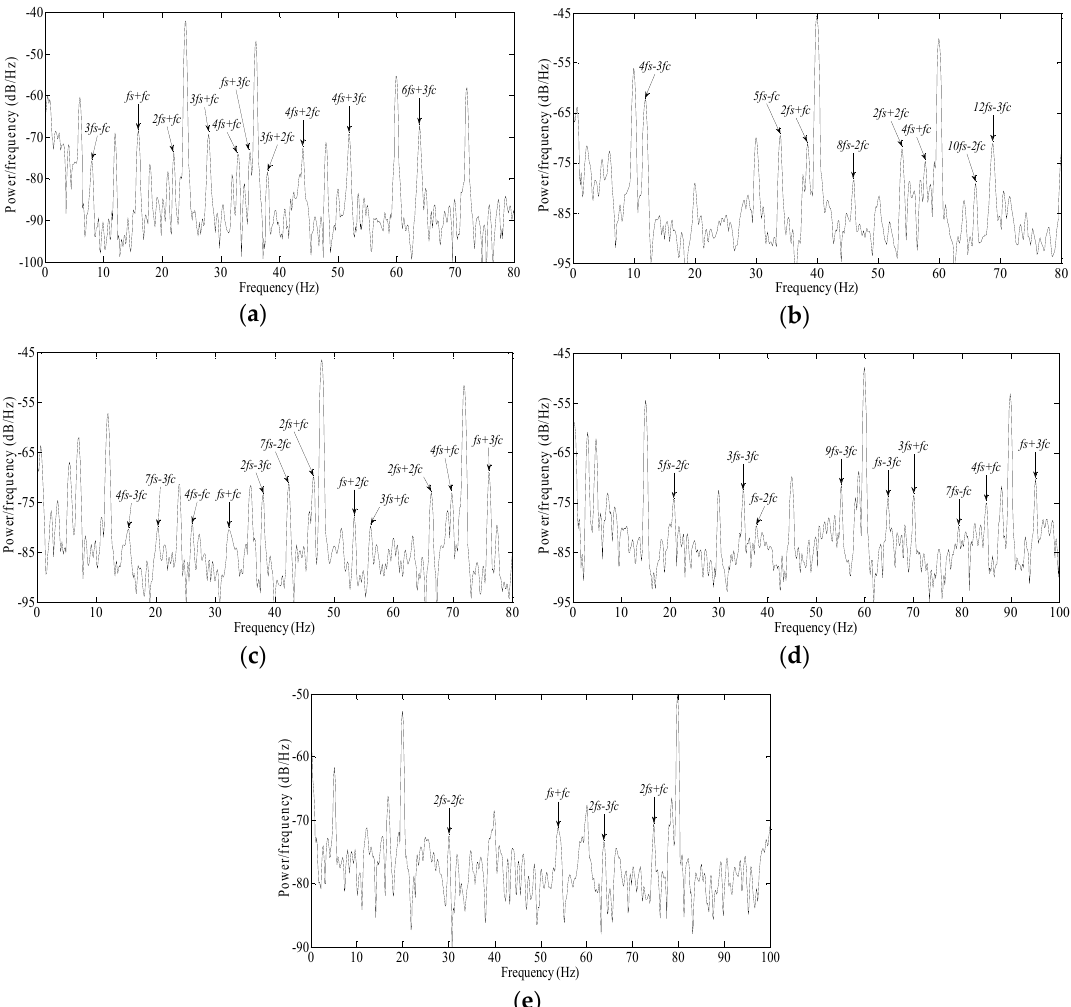
Figure 16. The squared envelope spectrum for di ff erent power supply frequency: ( a ) 6 Hz; ( b ) 10 Hz; ( c ) 12 Hz; ( d ) 15 Hz; ( e ) 20